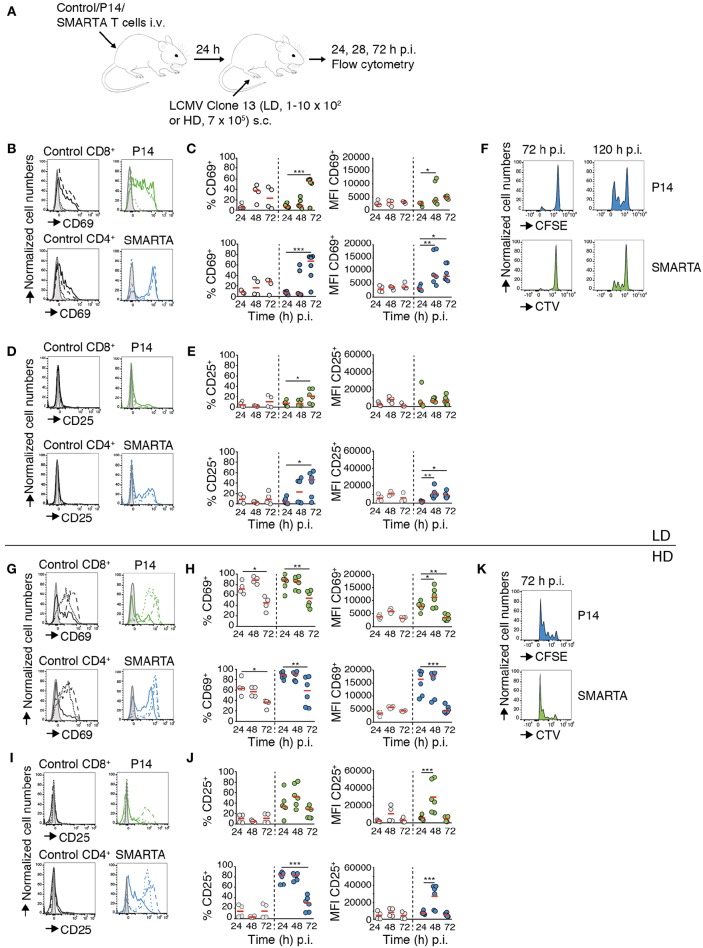
CD4+ and CD8+ T cell activation and proliferation kinetics correlate with LCMV inoculum. (A) Experimental layout. Activation of control T cells, P14, and SMARTA T cells was analyzed by flow cytometry at 24, 48, and 72 h post LD and HD LCMV infection. (B) CD69 expression on control (black), P14 (green), and SMARTA T cells (blue) at 24 (dotted line), 48 (dashed line), and 72 h (continuous line) post LD LCMV infection. (C) Percentage and MFI of CD69+ control (gray) and P14 (green) or SMARTA T cells (blue) post LD LCMV infection. (D) CD25 expression on control (black), P14 (green), and SMARTA T cells (blue) at 24 (dotted line), 48 (dashed line), and 72 h (continuous line) post LD LCMV infection. (E) Percentage and MFI of CD25+ control (gray) and P14 (green) or SMARTA T cells (blue) post LD LCMV infection. (F) Flow cytometry histograms of P14 (green) and SMARTA T cells (blue) at 72 and 120 h post LD LCMV infection. (G) CD69 expression on control (black), P14 (green), and SMARTA T cells (blue) at 24 (dotted line), 48 (dashed line), and 72 h (continuous line) post HD LCMV infection. (H) Percentage and MFI of CD69+ control (gray) and P14 (green) or SMARTA T cells (blue) post HD LCMV infection. (I) CD25 expression on control (black), P14 (green), and SMARTA T cells (blue) at 24 (dotted line), 48 (dashed line), and 72 h (continuous line) post HD LCMV infection. (J) Percentage and MFI of CD25+ control (gray) and P14 (green) or SMARTA T cells (blue) post HD LCMV infection. (K) Flow cytometry histograms of P14 (green) and SMARTA T cells (blue) at 72 h post HD LCMV infection. Each dot represents data from one mouse. Red lines depict median. Data are pooled from three independent experiments with a total of four to six mice per condition and time point. Statistical significance was analyzed using one-way ANOVA test. *p < 0.05; **p < 0.01; ***p < 0.001.